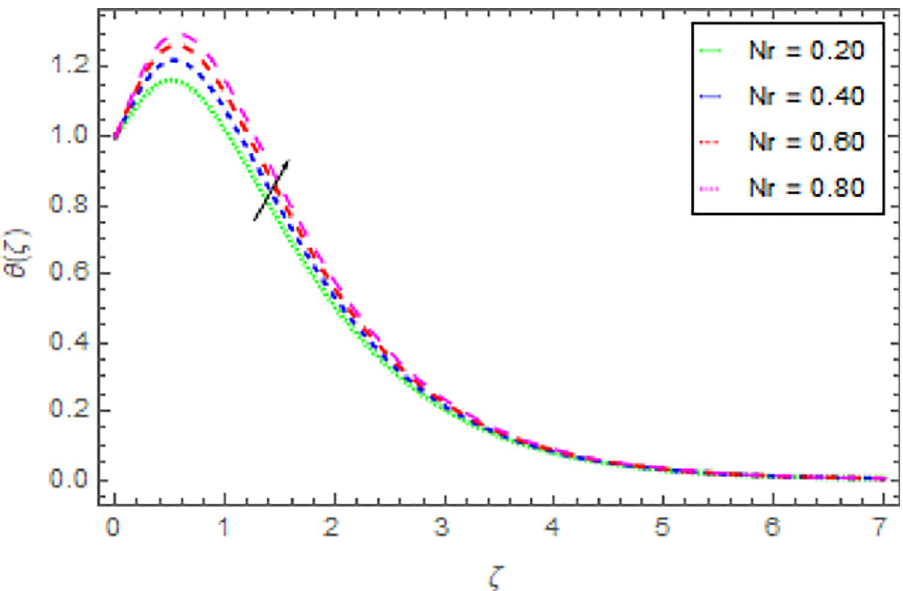
Fig 13. Deviation in nanofluid temperature against Nr Pr = 1000, m = 0.10, n = 1.00, M = 2.50, δ = 0.40, β = 1.00 and ϕ = 0.01 to ϕ =